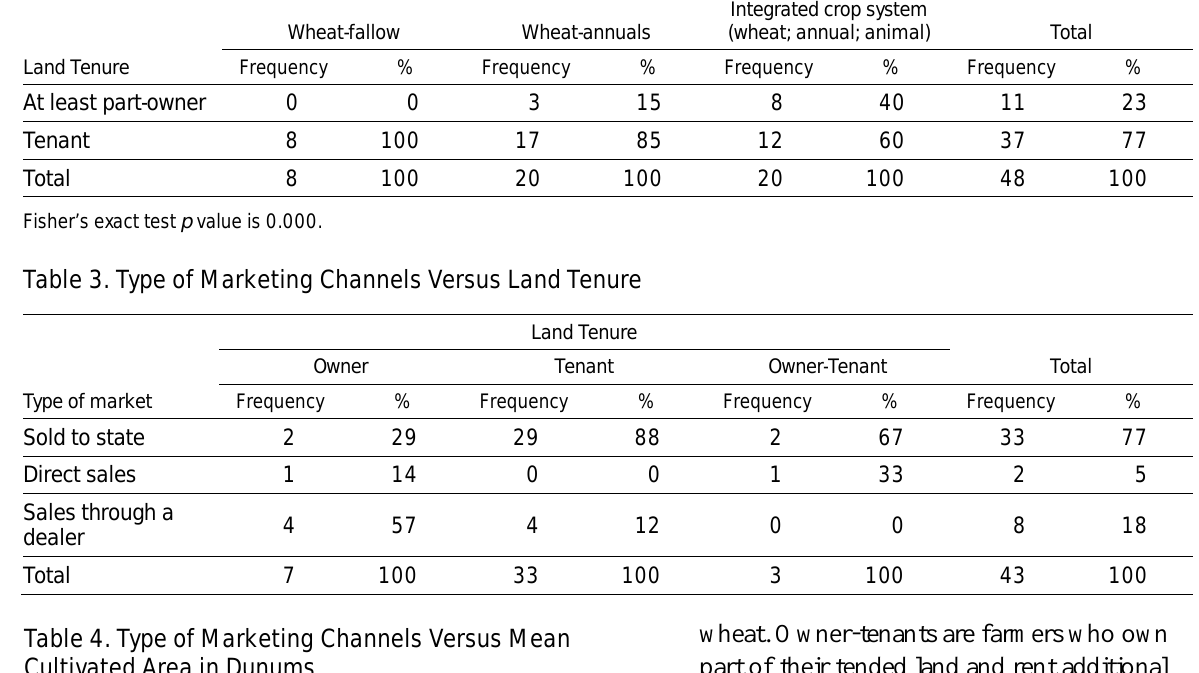
Table 2. Land Tenure Versus Cropping System